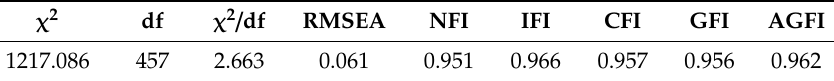
Table 4. Results of confirmatory factor analysis of the scale ( N = 483).